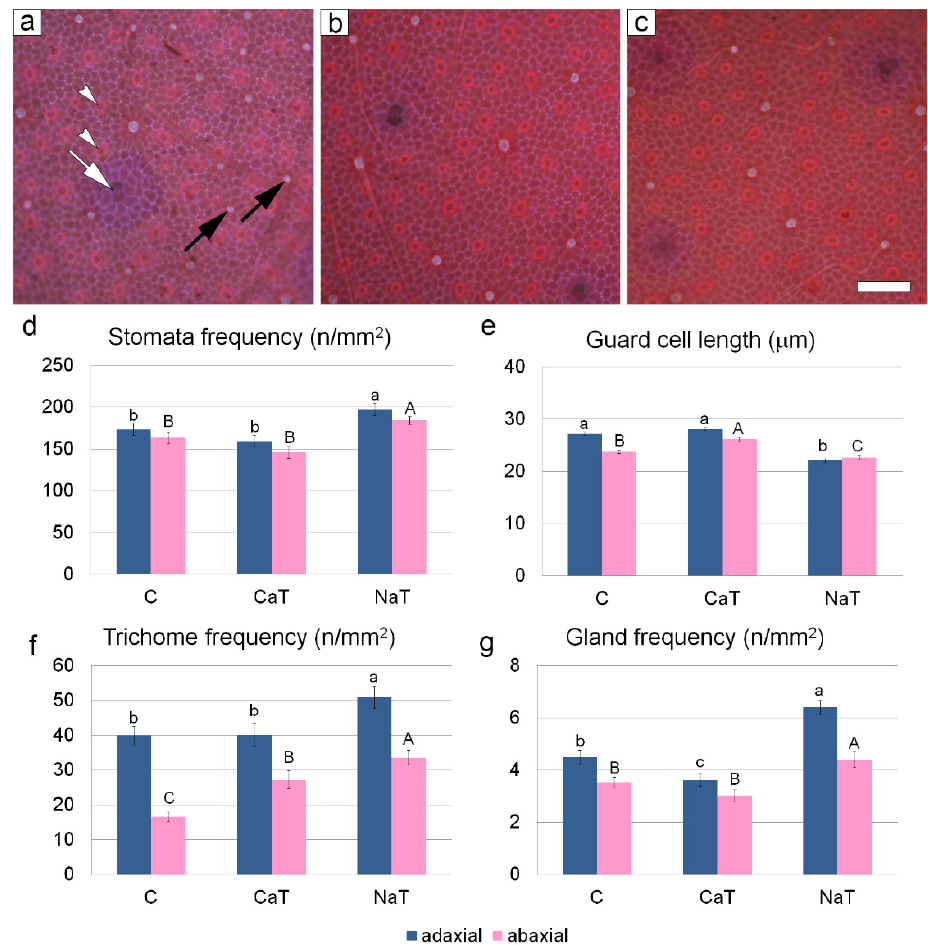
Figure 2. Epi-fluorescence microscopy views of upper epidermis of leaves of C. citrinus plants subjected to the different salinity treatments: ( a ) not salt control (C); ( b ) CaCl 2 salinity treatment (CaT); ( c ) NaCl salinity treatment (NaT). Stomata (white arrowheads), glands (white arrows) and the trichomes (black arrows) emit autofluorescence with different wavelengths. Effect of salinity on stomata frequency ( d ) and length of guard cells and size ( e ), trichome ( f ) and gland ( g ) frequency, on the adaxial and abaxial leaf lamina. Mean values and standard errors are shown. In graphs ( d – g ), Different letters correspond to significantly different values between treatments ( p < 0.05). Images in ( a – c ) are at the same magnification; scale bar = 100 μ m.